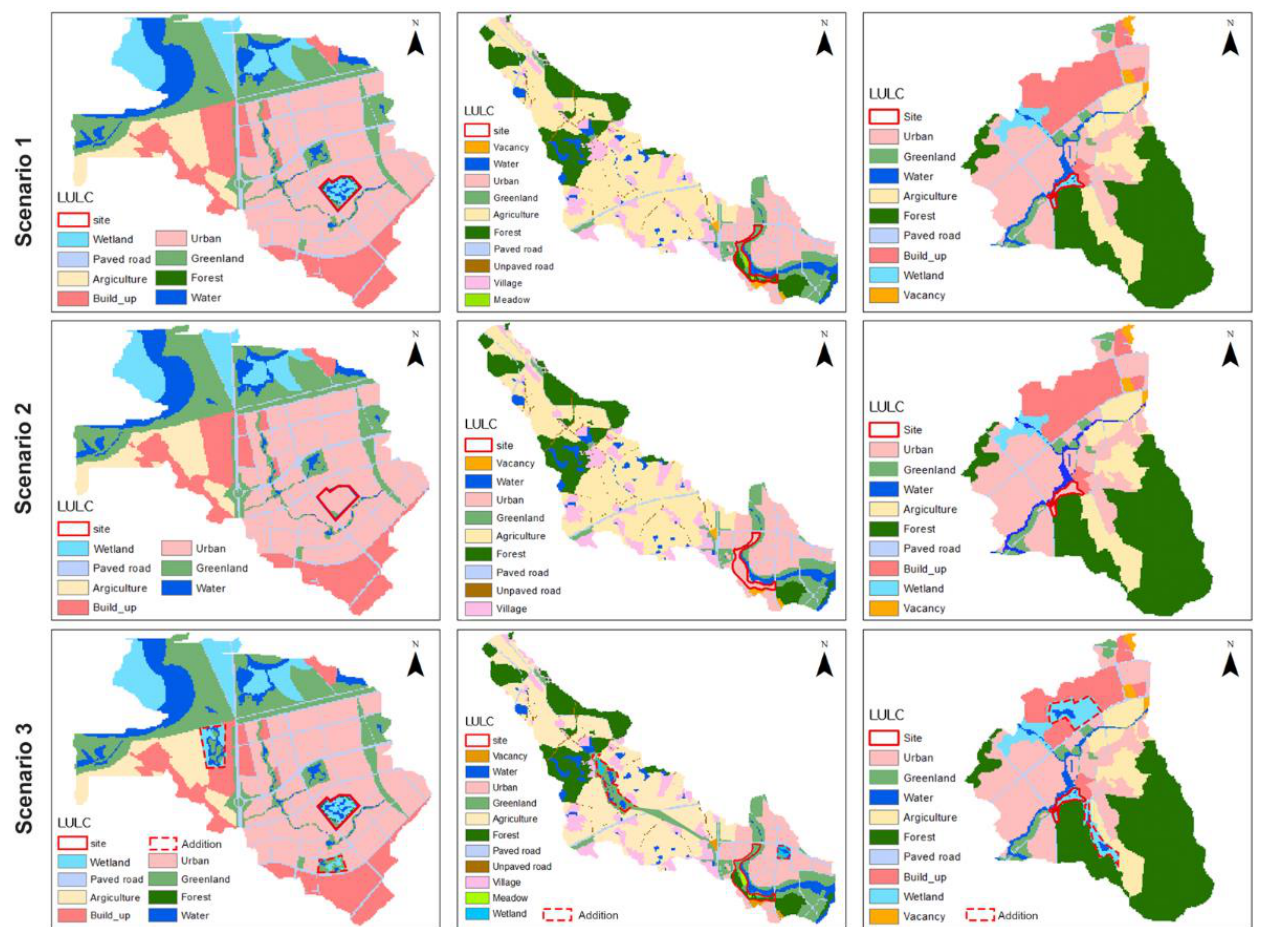
Figure 3. LULC of study area in three scenarios. From left to right in the picture shows the watershed area of Qunli Park, Luming Park and Mangrove Park.